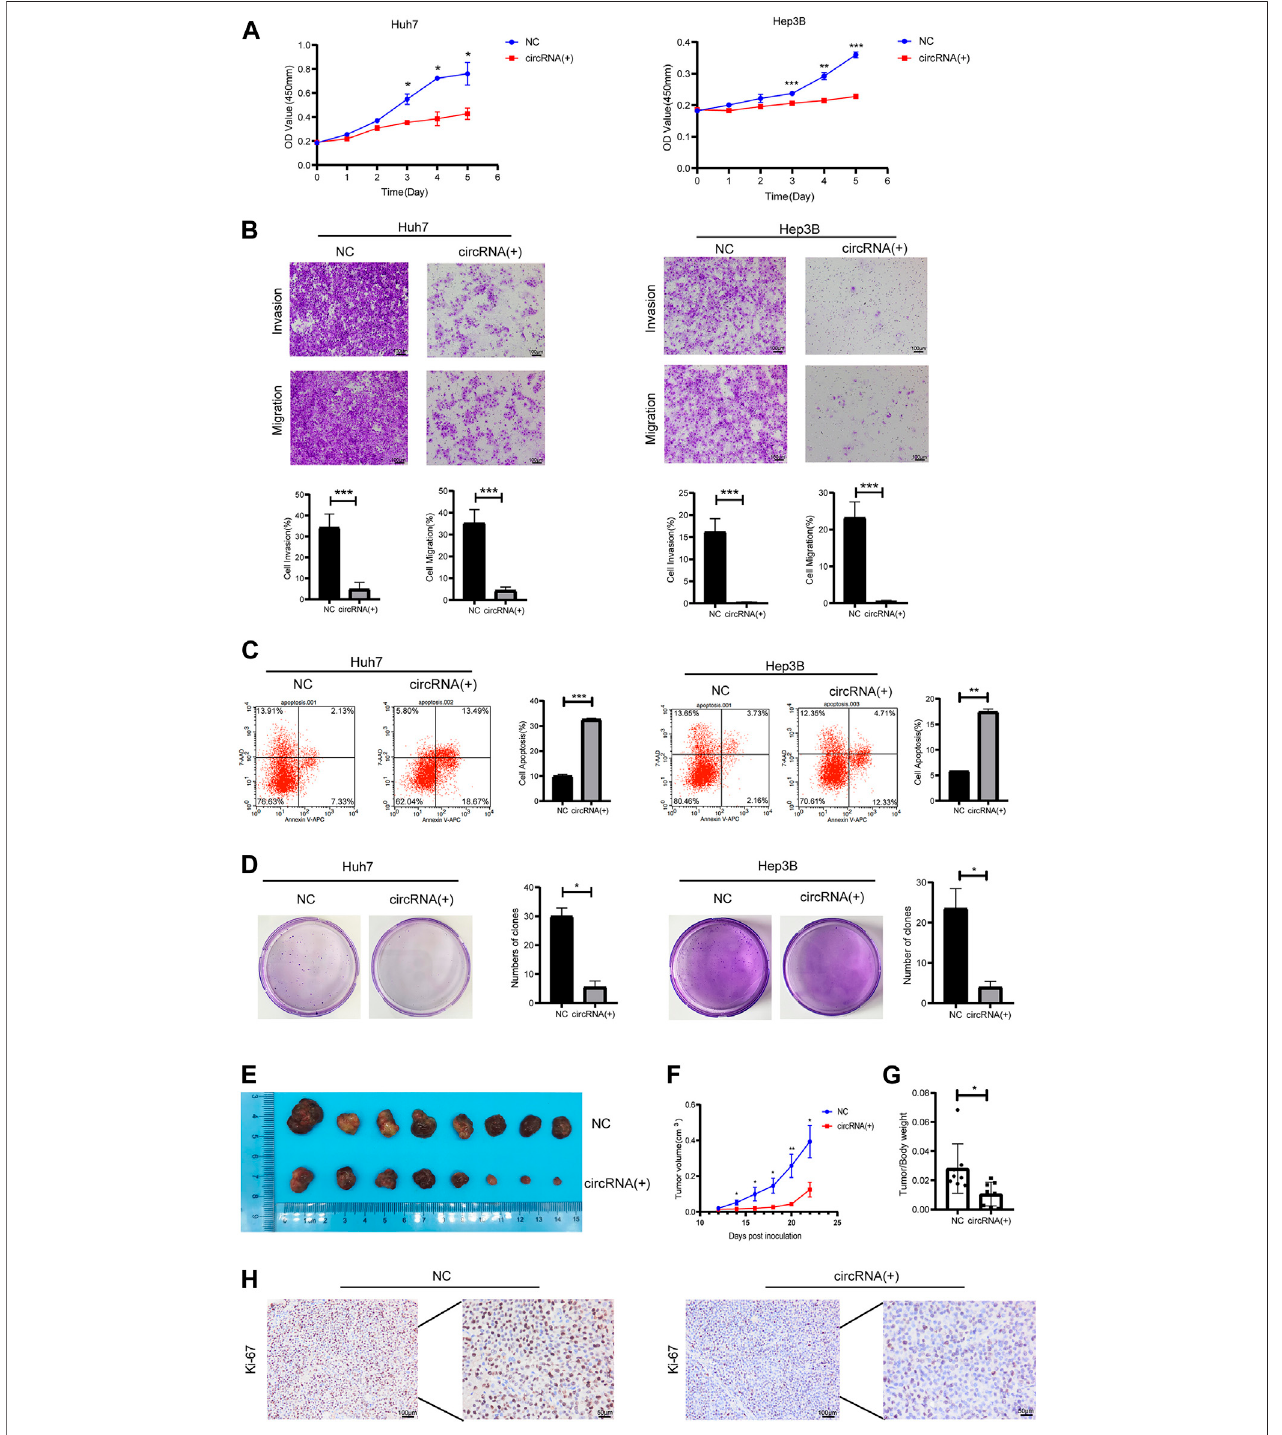
FIGURE 2 | Hsa_circ_0098181 mitigated the malignant phenotype of HCC in vitro and in vivo . After exogenous hsa_circ_0,098,181 delivery, the proliferation (A) , invasion, migration (B) , and colony formation (D) were suppressed in both Huh7 and Hep3B. (C) The apoptosis was promoted by hsa_circ_0098181 in Huh7 and Hep3B in AnnexinV-APC/7-AAD staining. (E) Exogenous hsa_circ_0,098,181 delivery inhibited the subcutaneous tumor formation ability of Huh7. (F) Growth curve of xenograft tumors derived from stable Huh7 cells infected with lentivirus ( n = 8). (G) The tumor weight/body ratio of the mice in hsa_circ_0098181 overexpression group waslower. (H) ImmunohistochemicalstainingforKi-67insubcutaneousxenograftmice(scale bar,100 µm).Datawereexpressed asmean±SD;* p < 0.05,** p < 0.01, *** p < 0.001.